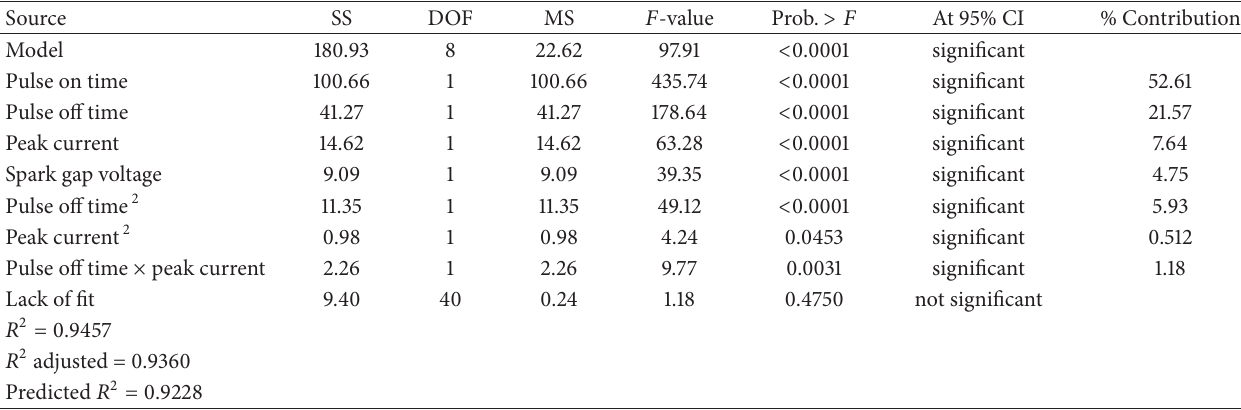
Table 3: The analysis of variance for main and interaction effects of parameters on